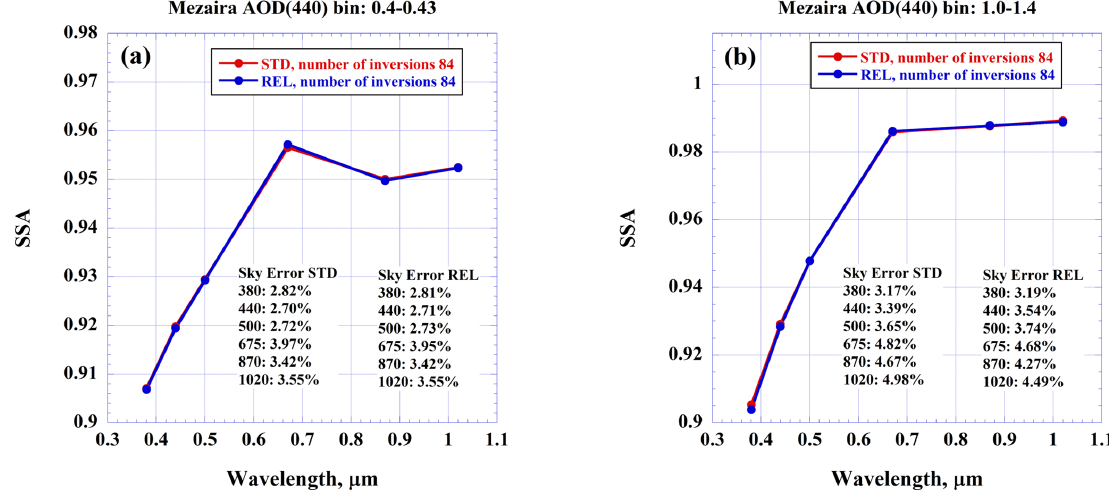
Figure 6. SSA averaged over AOD(440) bins for the Mezaira AERONET site: (a) 0.4–0.43 and (b) 1.0–1.4.